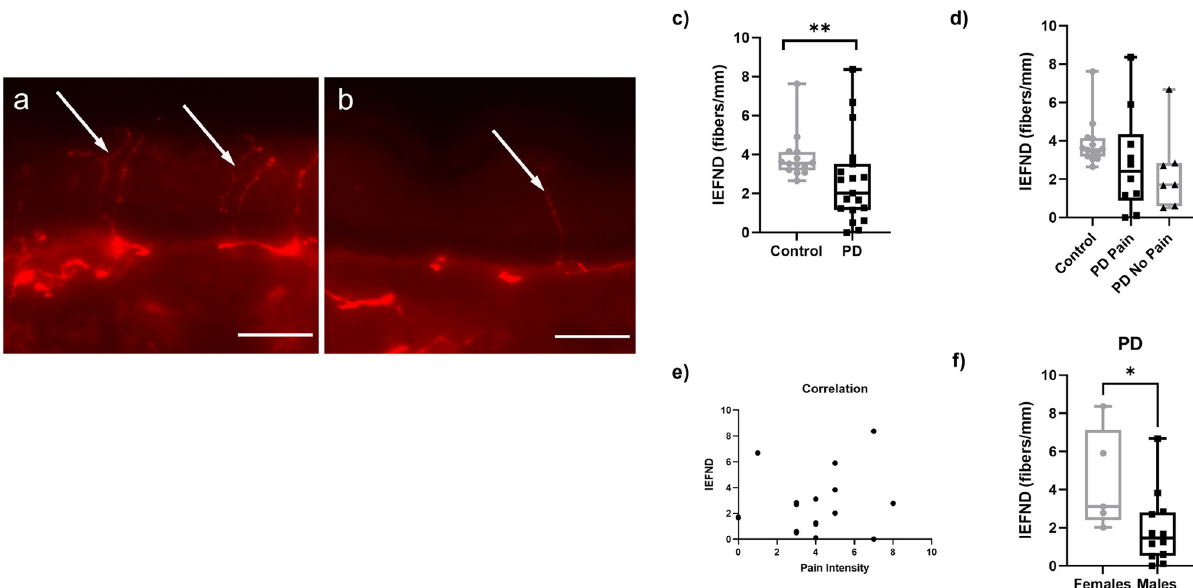
Fig 1. Quantification of intraepidermal nerve fiber density in skin punch biopsies obtained from the lateral lower leg. Representative images of immunohistochemical staining using PGP9.5 (red) antibody as a pan-neuronal marker in 40- μ m sections from the skin biopsy of a healthy control showing multiple intraepidermal nerve fibers (arrows). A representative biopsy from a healthy control (a) and a patient with PD (b); scale bars = 50 μ m. Quantification shows lower IENFD in PD compared to healthy control skin biopsies (c). No intergroup differences for the IENFD between PD Pain and PD No Pain patients (d). No correlation of IENFD and patients‘pain intensity (e). Lower IENFD in women with PD compared to men with PD (f). Data are expressed as median and range. Abbreviations: IENFD = intraepidermal nerve fiber density, PD = Parkinson’s disease, PGP9.5 = protein gene product 9.5. � P < 0.05, �� P < 0.01. Mann-Whitney-U test.